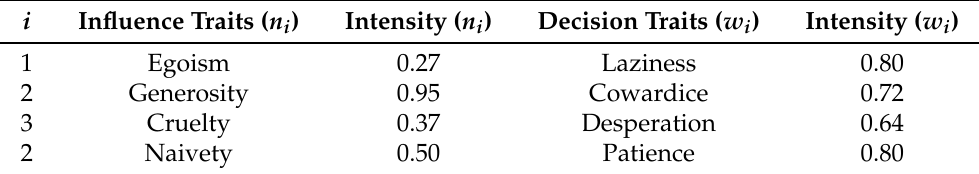
Table 8. The intensity of personality traits is classified as